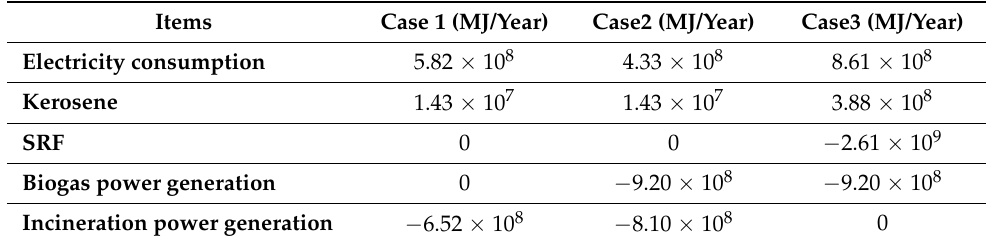
Table 13. Details of primary energy